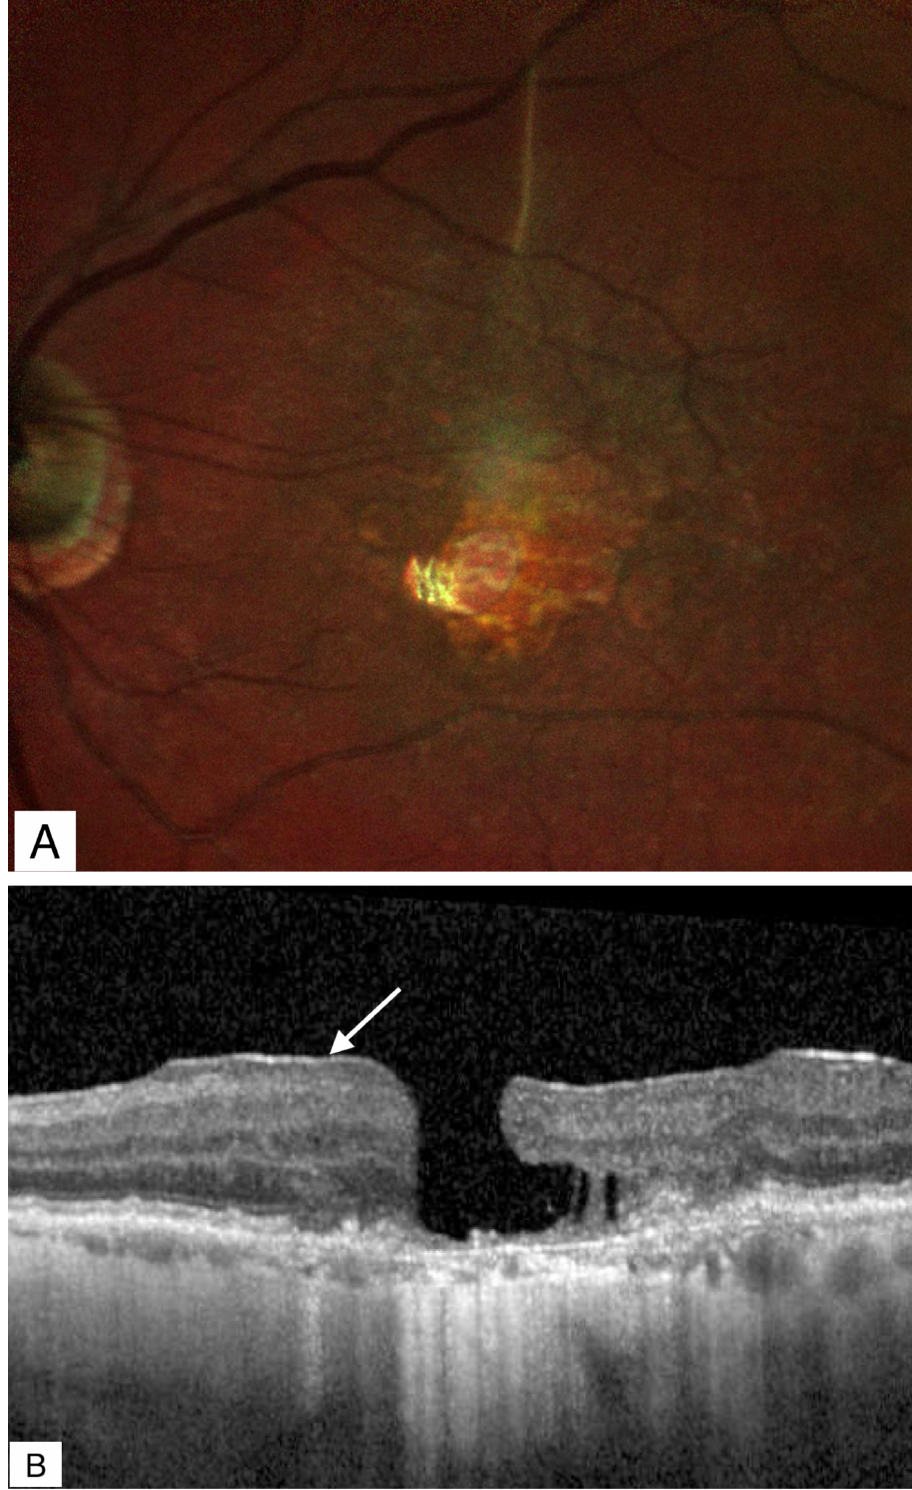
Figure 5. A 96-year-old man with long standing macular degeneration. The visual acuity was count- ing fingers. ( A ) Multicolor reflectance image showing some drusen and an irregular patch of central atrophy. ( B ) Spectral domain optical coherence tomography demonstrating residual tissue at the foveal floor confirming the presence of a secondary LMH. The arrow points to an ERM. LMH: la- mellar macular hole; ERM: epiretinal membrane. Degenerative LMH is a chronic and progressive condition. Its pathogenesis is poorly understood [16,17]. Many investigators suggested that foveal remodeling in the absence of overt tractional forces are at play [17,27,44,46,47]. However, according to Bringmann et al. [64,72], the initial event in both ERM foveoschisis and LMH is a tractional event that disrupts the Müller cell cone in the foveola or the connections to the foveal walls. This tractional event creates a schisis between the OPL and HFL. Cavitations emerge and en- large by a slow and chronic degeneration of Henle fibers [64]. Continuous chronic degen- eration of HFL coupled to an unknown event such as choroidal ischemia may lead to de- generative changes of the retinal outer layers causing central photoreceptor death and retrograde degeneration of bipolar and horizontal cells [64,72,102]. 7. Natural History The natural history of LMH is poorly understood. LMH may close spontaneously with extension of the ERP size over time [103–106]. ERP most likely represents Müller cell proliferation as a reactive process to retinal injury [46,48,106]. Conversely some eyes with a LMH may develop into a FTMH. Most of the eyes that converted from a LMH to a FTMH had an ERM and/or ERP suggesting that tangential traction could play a role in this situ- ation [44,46,49,77,107]. Alternatively, a poorly understood progressive degeneration of the foveolar architecture could be responsible for the progression to a FTMH. In these cases, the macular hole diameter was typically small, the edges were flat and there was limited